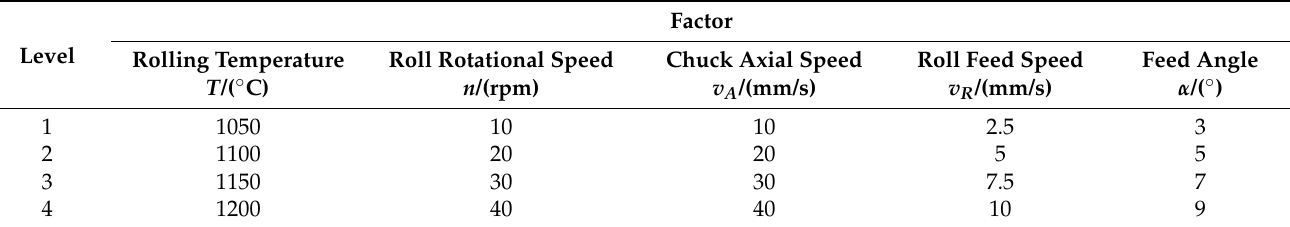
Table 3. Horizontal table of orthogonal test